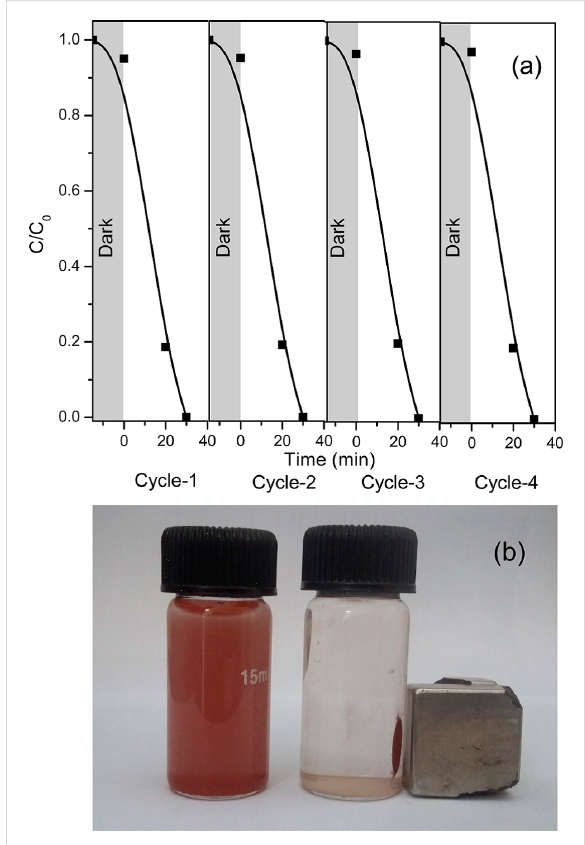
Figure 12: (a) Recyclability of TiO 2 /Fe 3 O 4 towards photoreduction of Cr(VI) up to 4 cycles, and (b) images of the magnetic separation of TiO 2 /Fe 3 O 4 . Reprinted with permission from [158], copyright 2016 American Chemical